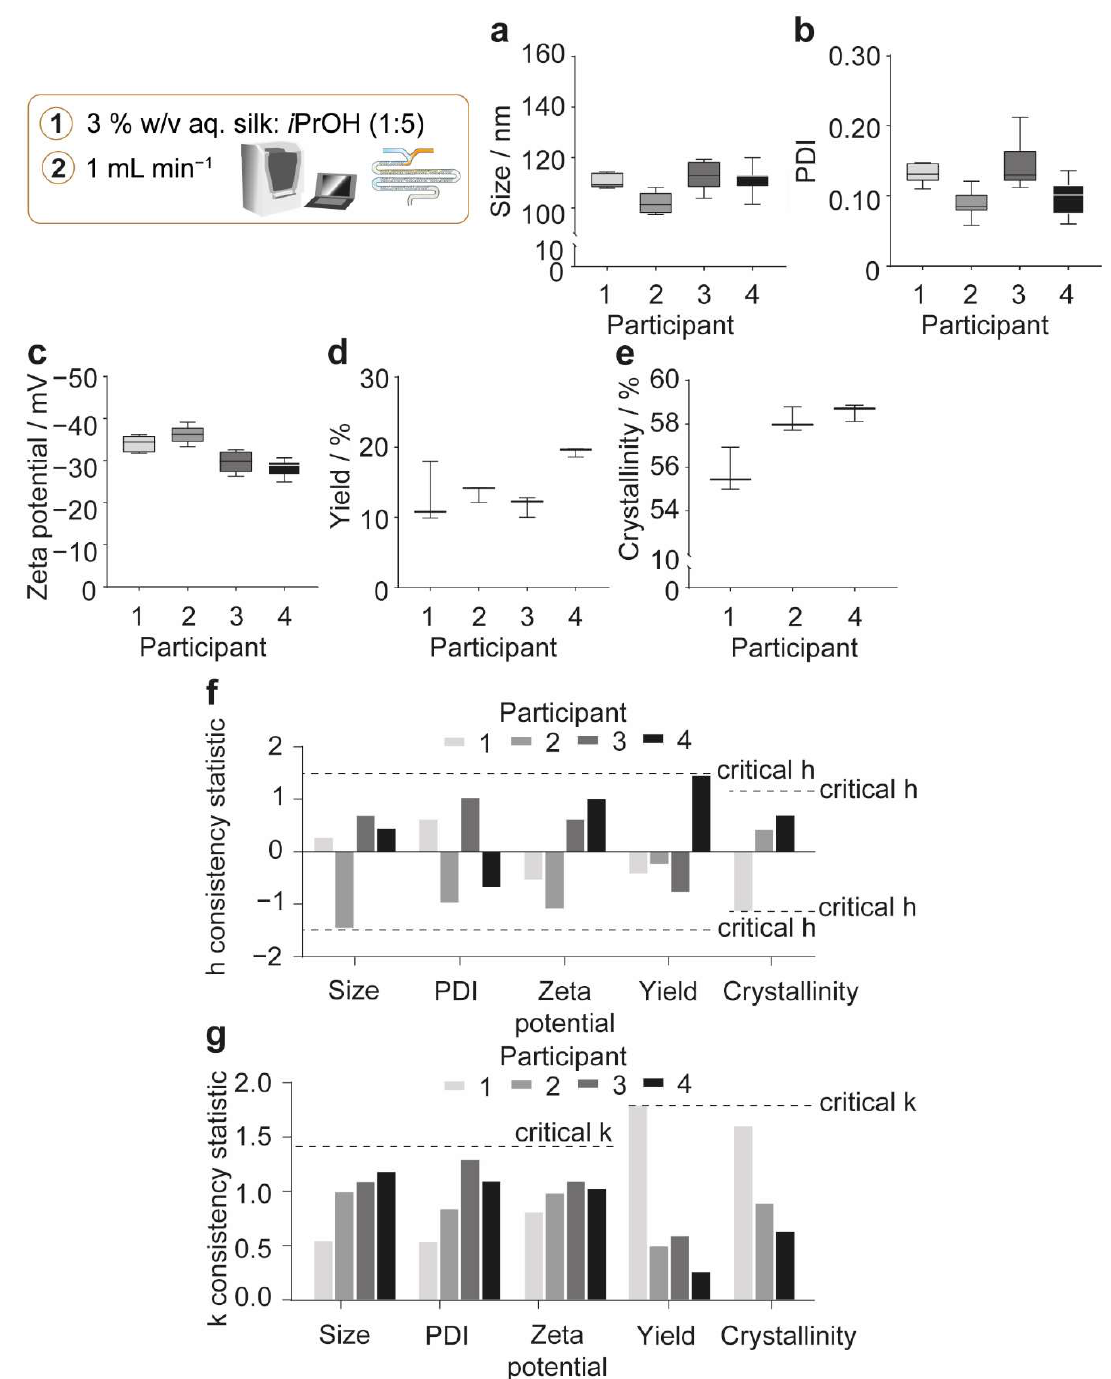
Figure 4. Variation observed in physicochemical properties and yield of silk nanoparticles manufactured in the NanoAssemblr TM as part of a round robin study. ( a ) Hydrodynamic diameter, ( b ) polydispersity index (PDI), ( c ) zeta potential, ( d ) yield, and ( e ) β-sheet crystallinity of silk nanoparticles. ( f ) The h and ( g ) k consistency statistics of nanoparticles manufactured using four participants for all properties except for crystallinity, which were calculated using the data from three participants. Participants 2 and 4 produced four nanoparticle batches for DLS and ELS studies, and participants 1 and 3 produced three nanoparticle batches. Yield and crystallinity were analyzed across three nanoparticle batches for all participants. Data from participants 2 [43], 3 [14], and 4 [15] were published previously.